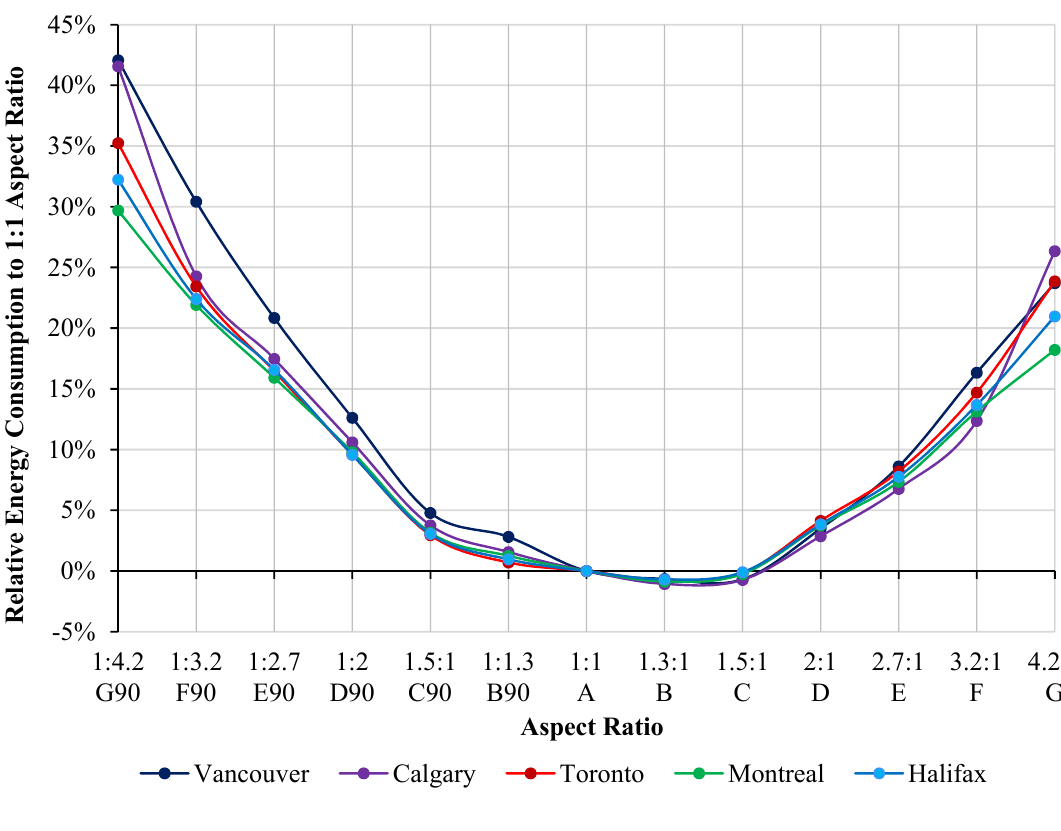
Figure 13. Relative energy consumption in heating for aspect